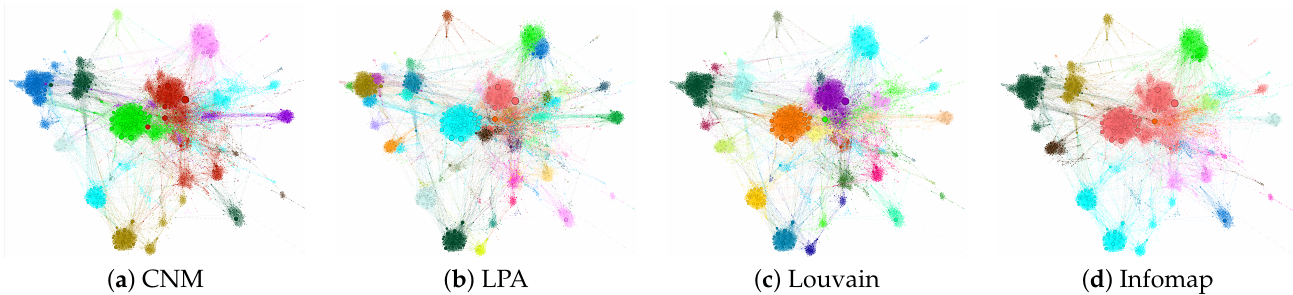
Figure 1. Comparison between different community detection algorithms on the Politicians network. Layout: Gephi’s ForceAtlas 2.